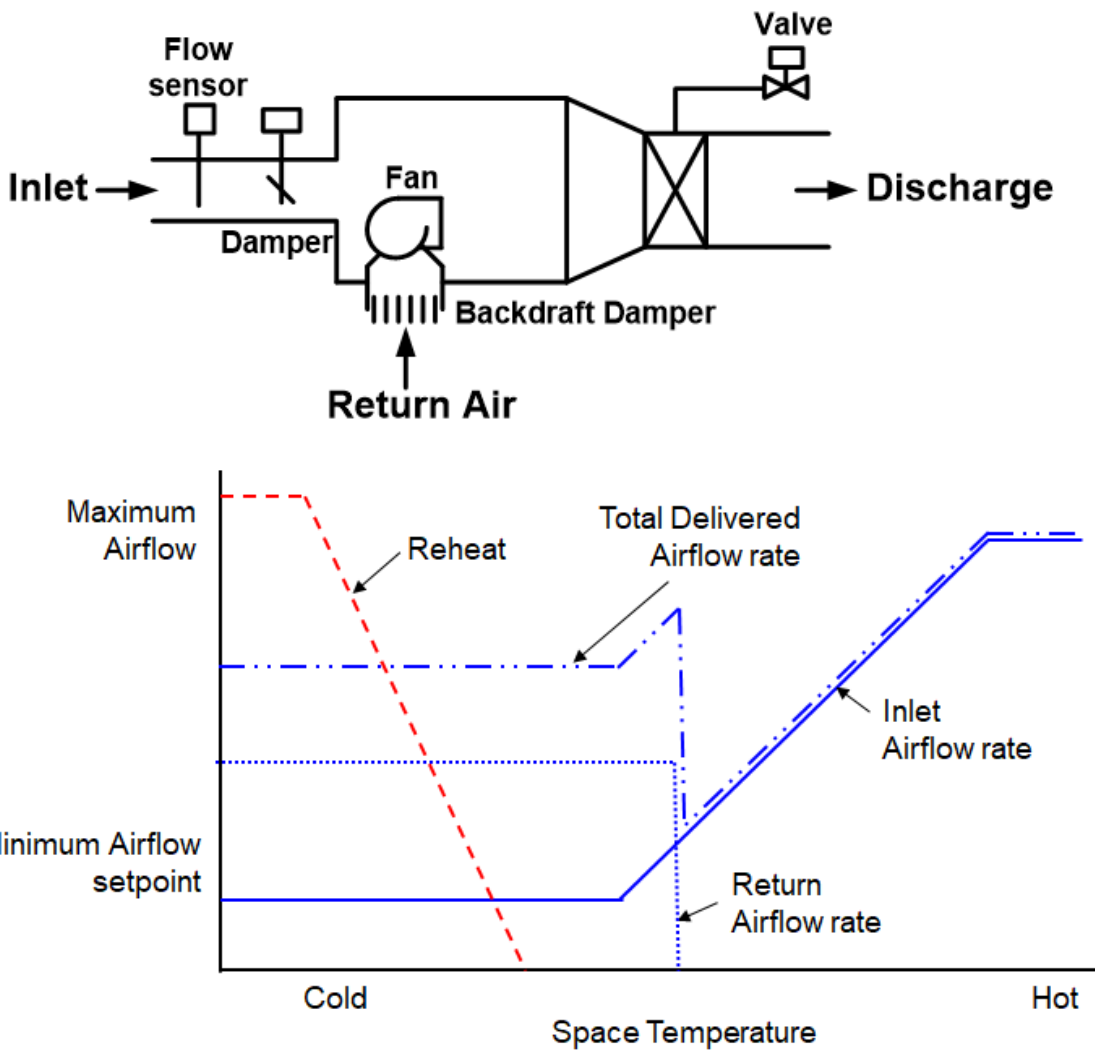
Figure 5. Parallel fan-powered VAV terminal unit and control sequence [16].